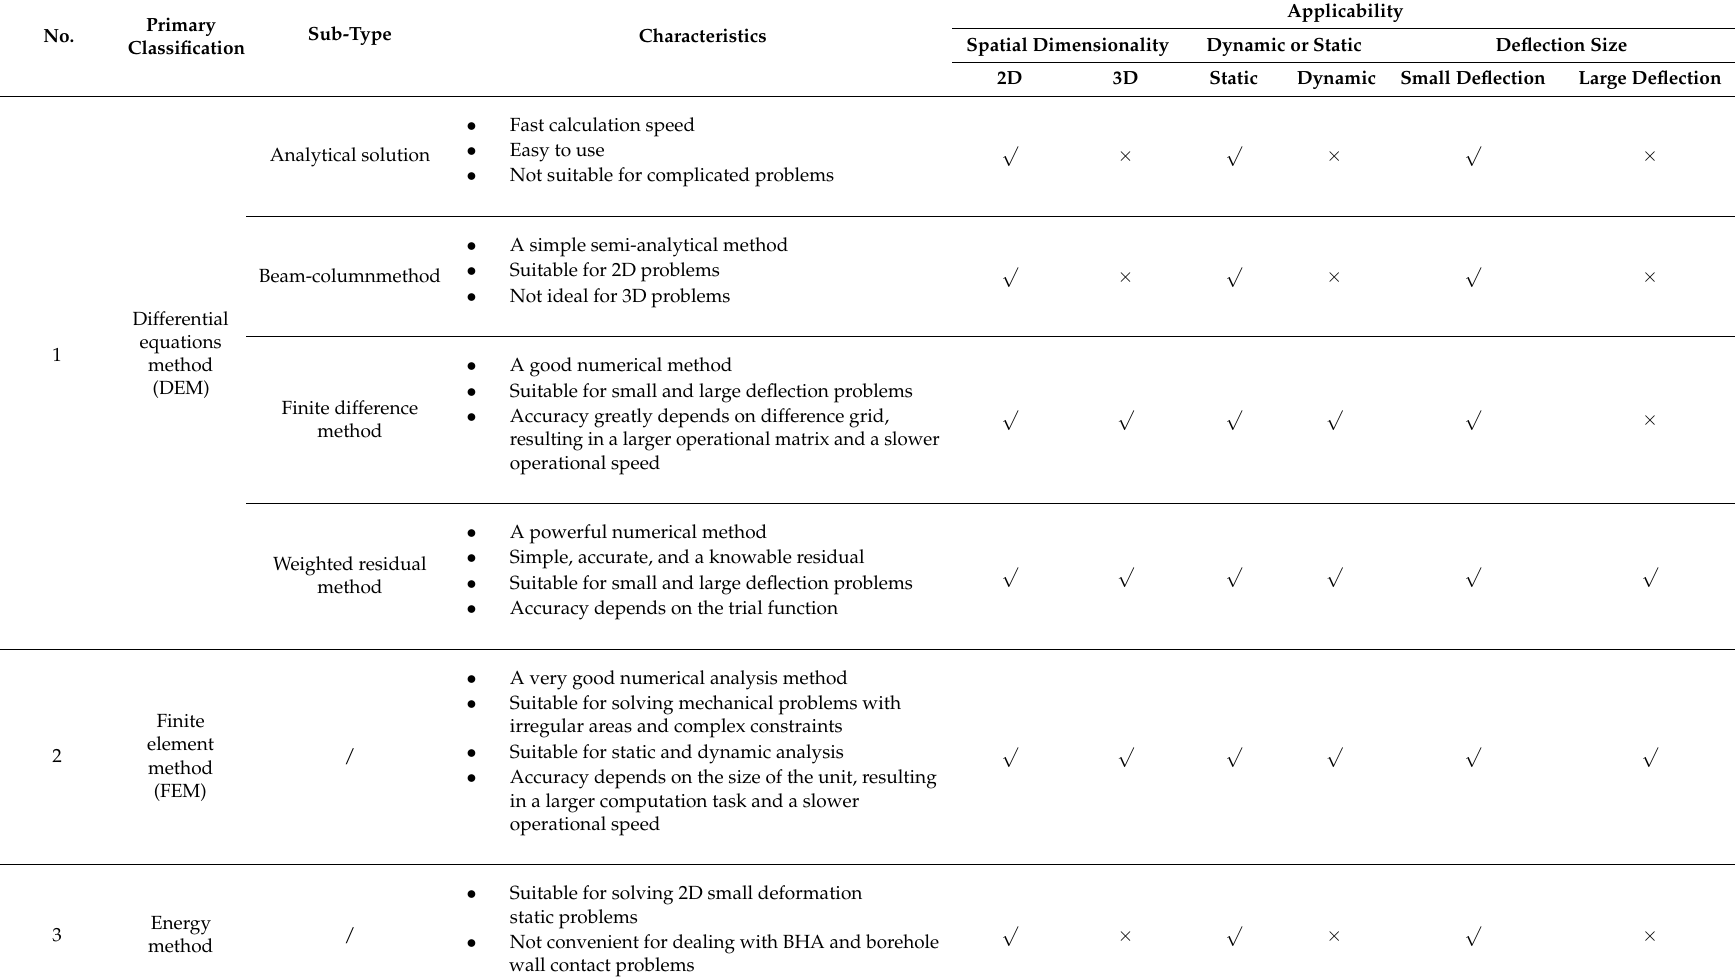
Table 1. Mechanical analysis methods of drill-string and their applicability. Modified from Li et al. [12].